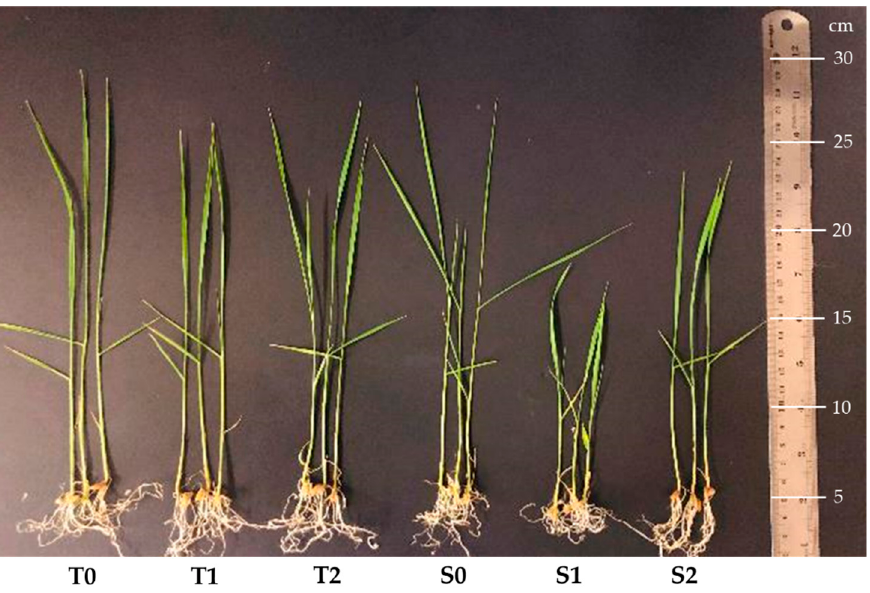
Figure 1. Phenotypic responses of rice under salt stress. T0, tolerant variety (BC15) control; T1, salted BC15; T2, salted BC15 + MgSO 4 ; S0, susceptible variety (DT84DB) control; S1, salted DT84DB; S2, salted DT84DB + MgSO 4 .